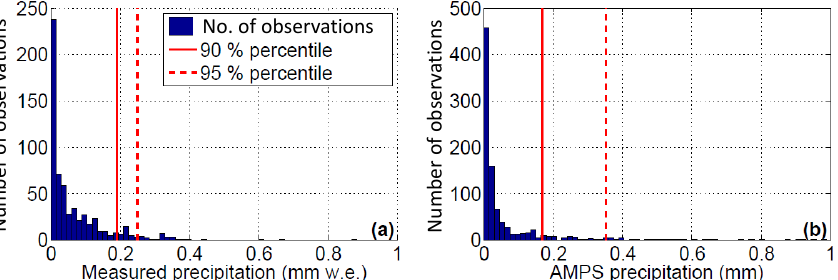
Figure 1. Histogram of daily precipitation amounts for (a) measurements and (b) AMPS archive data for the period 2008–2010.